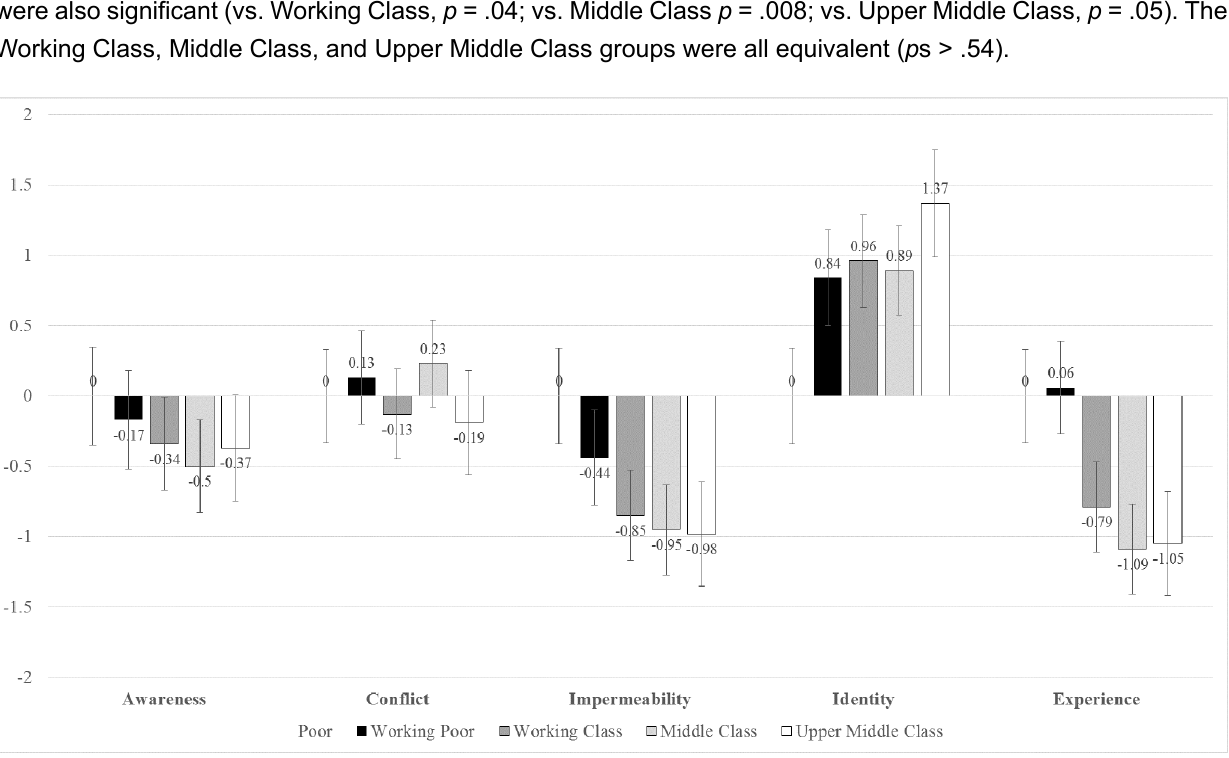
Figure 2. Estimates of class category averages for each dimension of class consciousness. Note. All intercepts estimated relative to the Poor category (intercept = 0). Error bars reflect standard errors of the